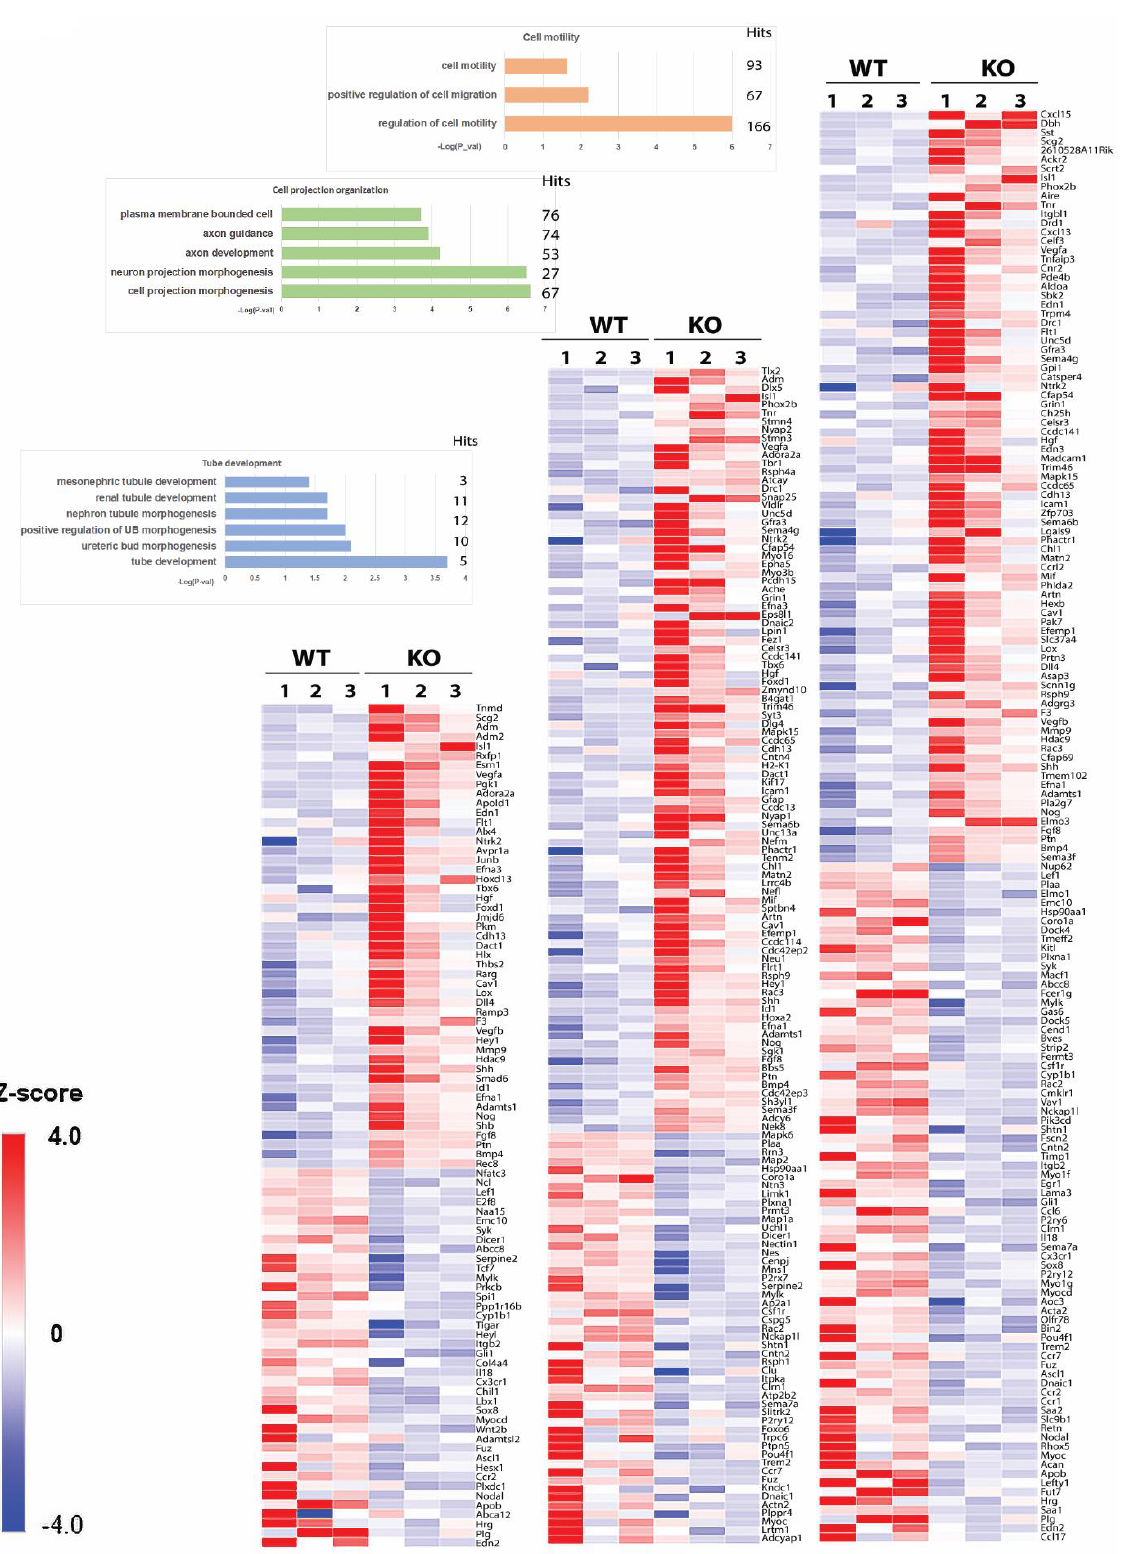
Figure 5. RNAseq analysis of Fuzzy − / − kidneys. Gene ontogeny (GO) pathway enrichment in wildtype and E14.5 Fuzzy − / − kidney RNA samples. The upregulated gene expression is depicted in red, downregulated gene expression is in blue. KO– Fuzzy − / − samples. Embryonic kidney(s) from each E14.5 embryo was used per sample; 3 embryos per genotype were dissected.